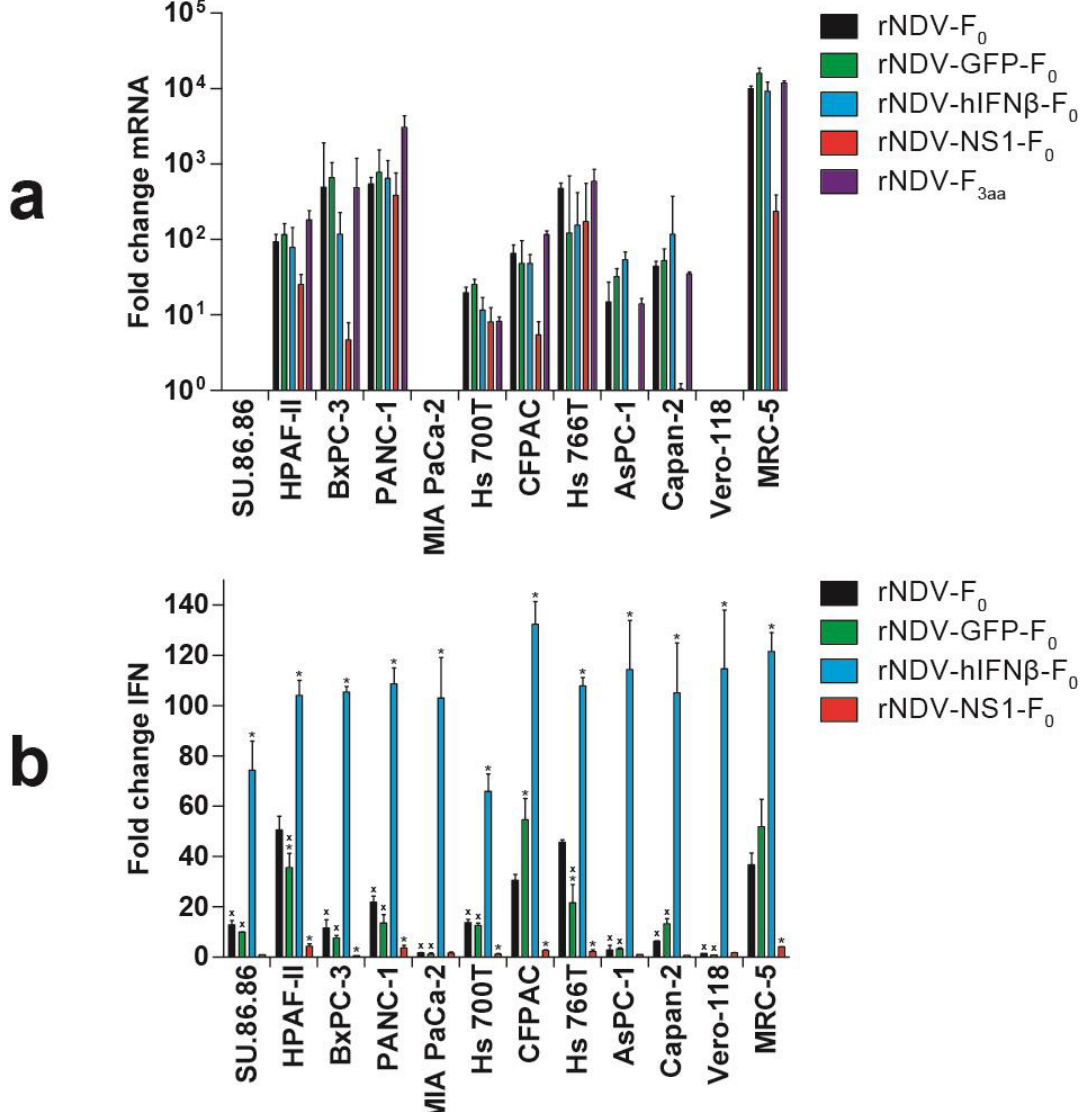
Figure 3. IFN responses upon inoculation with rNDVs. Cells were either mock inoculated or inoculated with the indicated rNDV at m.o.i. 3. After 24 h: ( a ) RNA was isolated and quantitative real-time polymerase chain reaction (qRT-PCR) was performed for endogenous hIFNβ mRNA. Results are presented as fold change gene induction of treated versus mock treated cells calculated using the 2 −ΔΔ C T method [31]. Means and ranges of triplicate experiments are plotted; ( b ) Supernatants were tested for functional IFN protein content using an ISRE-luc bioassay [14]. Results are presented as fold change in luminescence compared to mock inoculated cells. Means and standard deviations of triplicate experiments are plotted. x = p < 0.05 vs. MRC-5 (one-way ANOVA + Bonferroni post-test), * = p < 0.05 vs . rNDV-F 0 (one-way ANOVA + Bonferroni post-test).